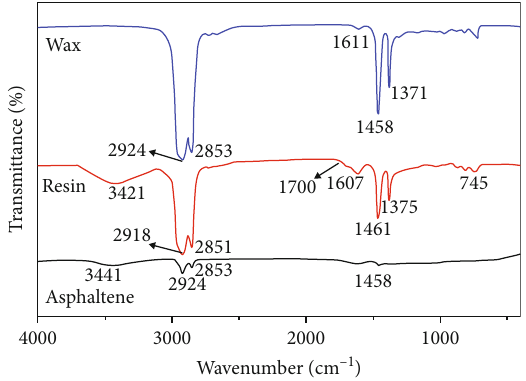
Figure 5: The infrared spectrum of the asphaltene, resin, and wax obtained.